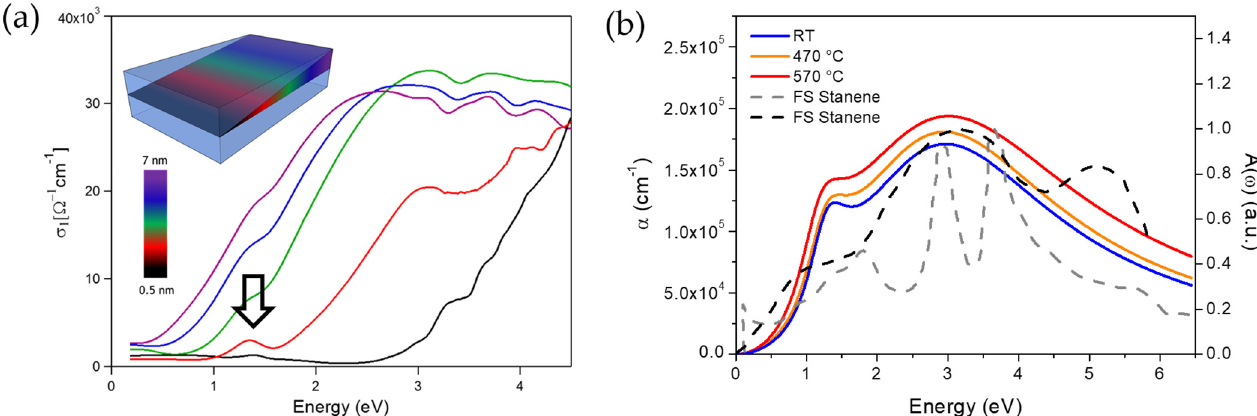
Figure 3. Optical characterization of silicon and tin nanosheets grown on c-Al 2 O 3 . ( a ) real part of the optical conductivity, σ 1 ( ω ), of silicon nanosheets with different thicknesses (see color scale). Samples with 0.5 nm thickness (black curve) show an absorption peak around 1.4 eV superimposed to a nearly flat background in the whole IR range. Adapted with permission from Ref. [14]. ( b ) Optical absorption coefficients, α ( ω ), of 0.5 nm-thick tin films deposited at different temperatures, from room temperature to 570 °C. The absorption coefficients show a quite similar shape characterized by two broad peaks centered at nearly 1.25 and 3 eV and are superimposed to two different calculated absorbance spectra of freestanding stanene (gray-dashed from Ref. [57] and black-dashed from Ref. [58]). Adapted with permission from Ref.